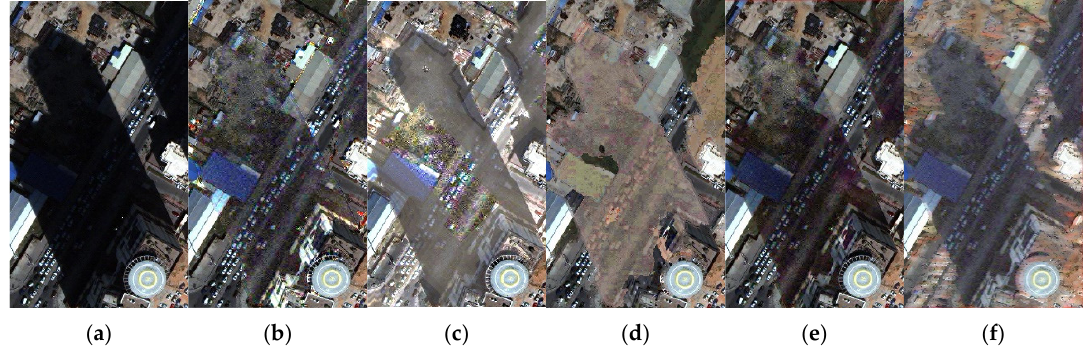
Figure 17. Shadow removal details of the methods in experimental data 1: ( a ) original image; ( b ) proposed; ( c ) Shor’s; ( d ) Guo’s; ( e ) Yu’s; and ( f ) Bauer’s.